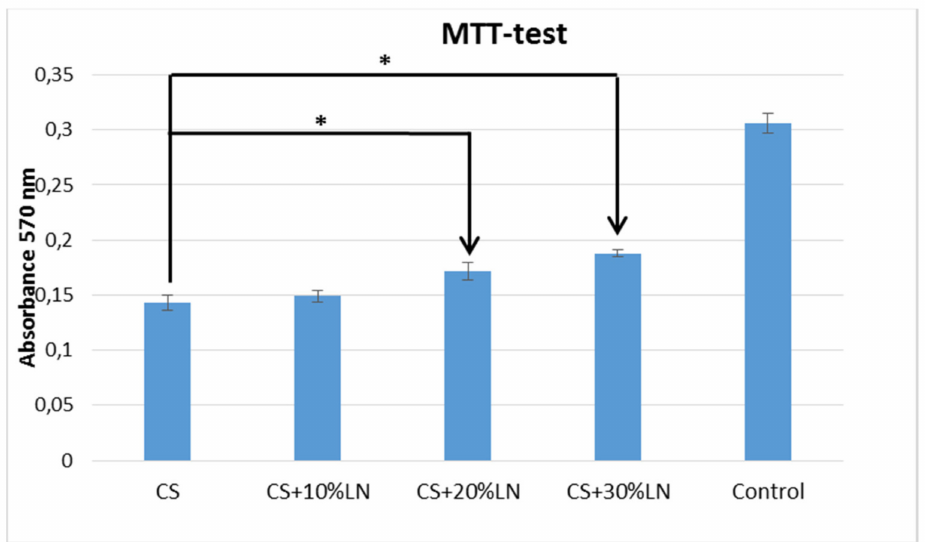
Figure 8. The viability and proliferation of human dermal fibroblasts on surfaces of film matrices and cultural polystyrene surface (control) as determined by MTT assay. The MTT test involved human dermal fibroblasts cultured on the surface of the chitosan-based nanocomposite matrices with the addition of 0, 10, 20, and 30 wt% lignin for 4 days. Cells cultivated on polystyrene surface served as control. Here, the optical density correlates with the number of viable cells. * p <